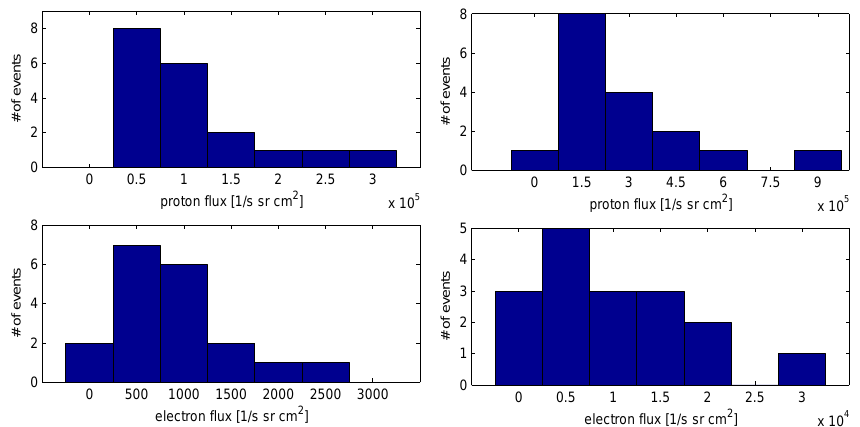
Fig. 2. Histograms of the proton and electron fluxes observed in the exterior cusp (left) and the high-latitude dayside plasma sheet (right).